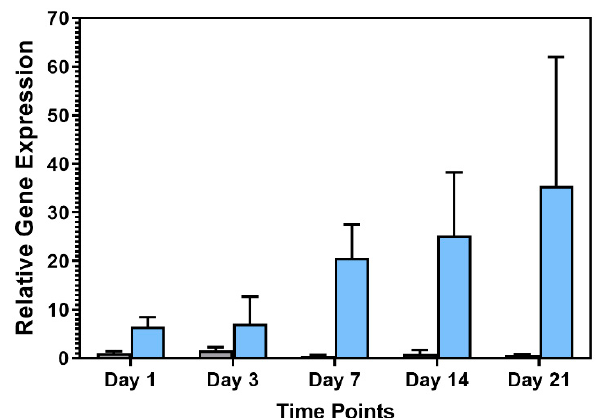
Figure 6. Relative levels of Pref-1 mRNA expression in hASCs (grey bars) and hWJSCs (blue bars). Data is shown as Pref-1 expression relative to not induced cells at each time point ( n = 6 independent isolations for all time points with exception to day 3 where n = 3). Gene expression levels were normalized to the following reference genes: PPIA, TBP, YWHAZ ( ∆ Ct), after which they were normalized to control (not induced) cells ( ∆∆ Ct). Error bars represent the standard error of the mean (SEM). Unpublished, original data.